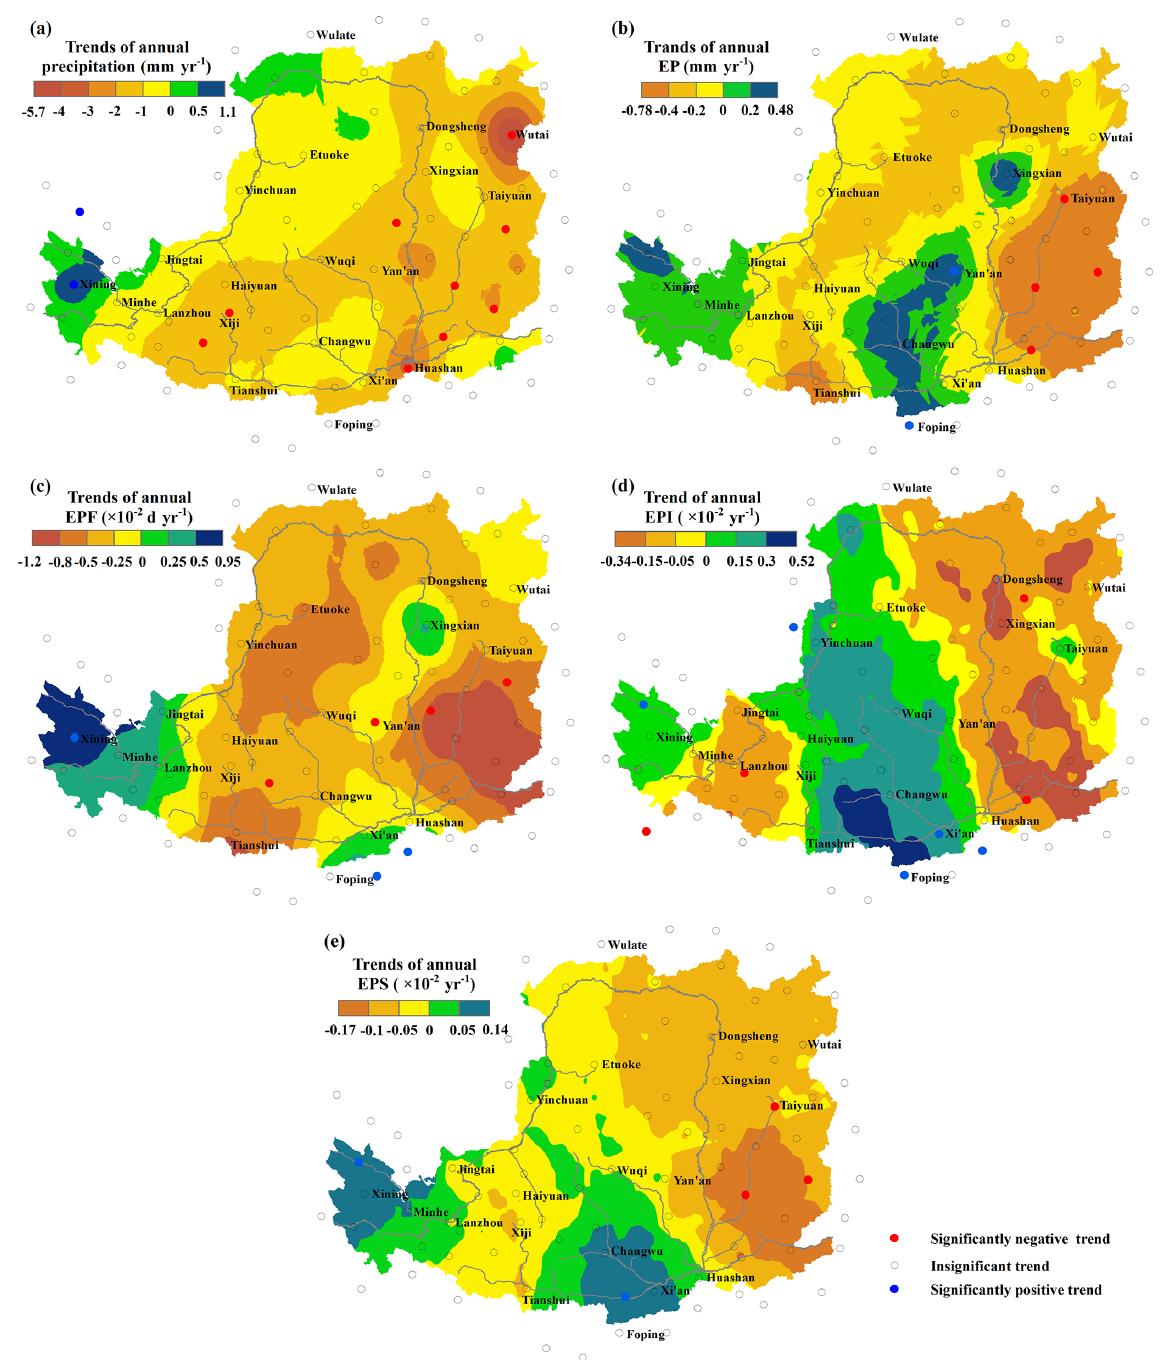
Figure 4. The spatial distribution of the trends and the stations with significant trends ( p < 0 . 1) for (a) annual precipitation, (b) annual EP, (c) annual EPF, (d) annual EPI, and (e) annual EPS in the LP from 1961 to